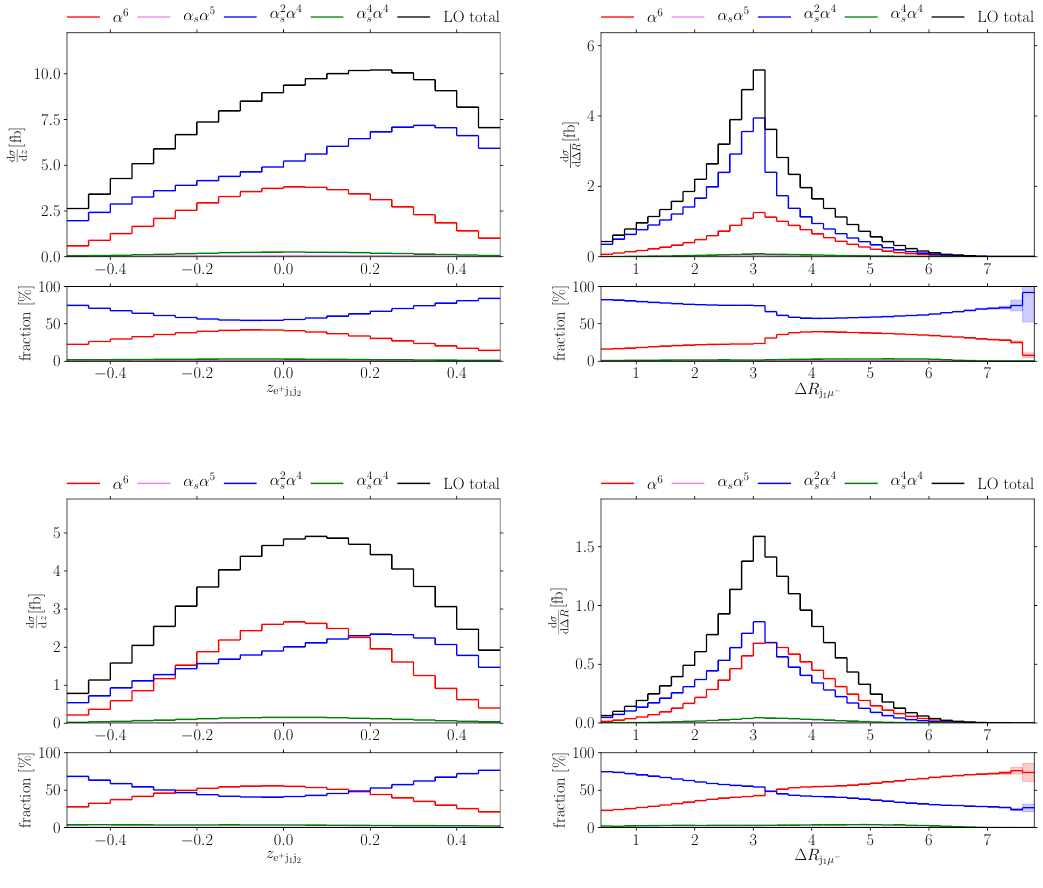
Figure 7. Differential distributions at LO in the Zeppenfeld variable (left) and the ∆ R separation of the hardest jet and the muon (right) in the VBS (top) and the Higgs setup (bottom). The upper panels show the absolute EW contribution at (cid:0) (cid:1) contribution at α 2 α 4 , the loop-induced contribution at s O The lower panels show the relative contributions normalised to the sum of all contributions. Shaded bands denote integration